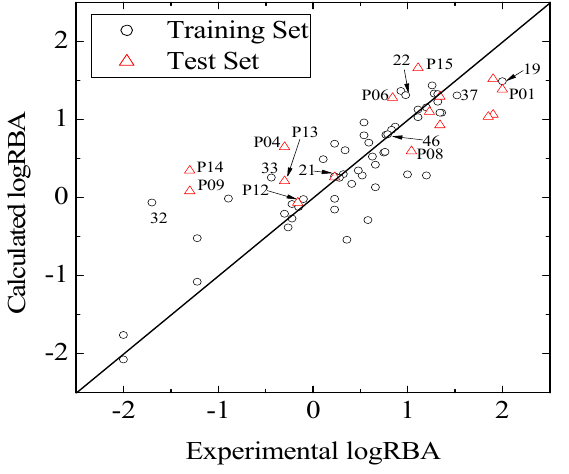
Figure 2. Plots of experimental logRBA versus calculated values of training and test sets.